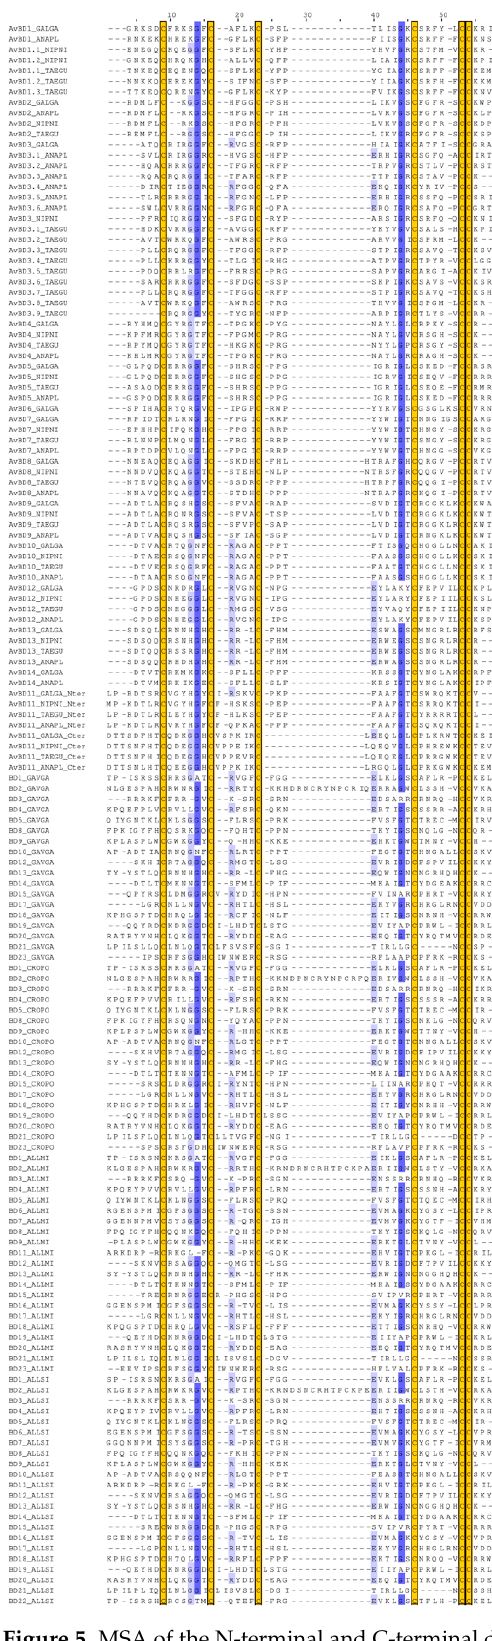
Figure 5. MSA of the N ‐ terminal and C ‐ terminal domains of AvBD11 with monodomain AvBDs and crocodile β‐ defensins. MSA was performed with MAFFT and drawn with Jalview with a blue colour gradient (100% of identity for dark blue) and trimmed at each extremity to adjust to the length of the N ‐ terminal and C ‐ terminal domains of AvBD11. Conserved cysteine residues are highlighted in yellow boxes. Bird species acronyms: ANAPL, Anas platyrhynchos (duck); GALGA, Gallus gallus